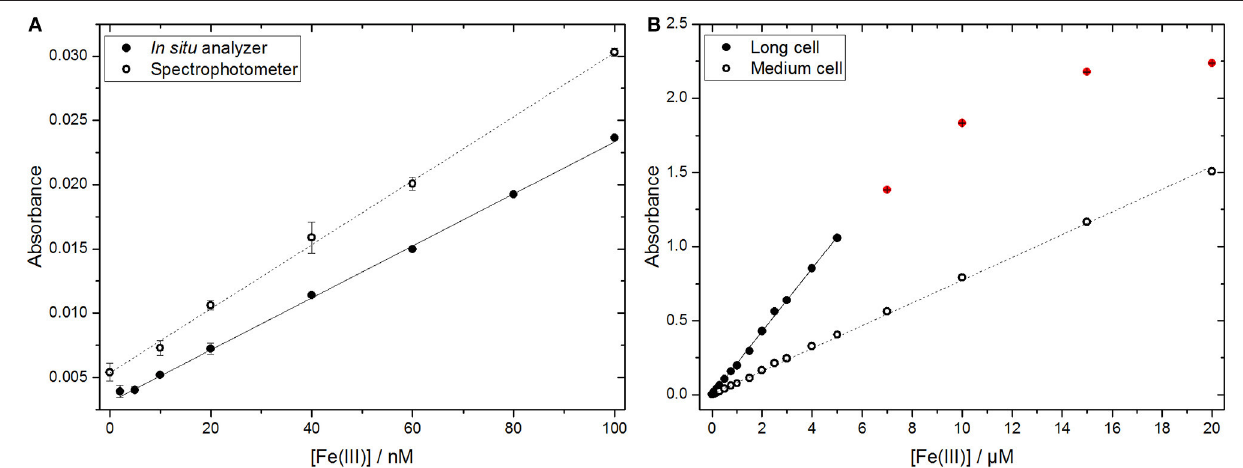
FIGURE 2 | Calibration and detection range of the in situ analyzer. (A) Calibration curves for Fe(III) standards obtained with the long cell of the in situ analyzer produced a molar extinction coefficient of 22,100 ± 240 L · mol − 1 · cm − 1 ( n = 4, filled circles plotted ± standard deviation, R 2 = 0.999) compared to a benchtop spectrophotometer derived molar extinction coefficient of 27,200 ± 380 L · mol − 1 · cm − 1 ( n = 3, open circles plotted ± standard deviation, R 2 = 0.999). (B) The linear range for Fe detection with the long (filled circles) and medium (open circles) cells of the analyzer ( n = 4), error bars are within the symbols. Data points outside the linear response are presented in red.